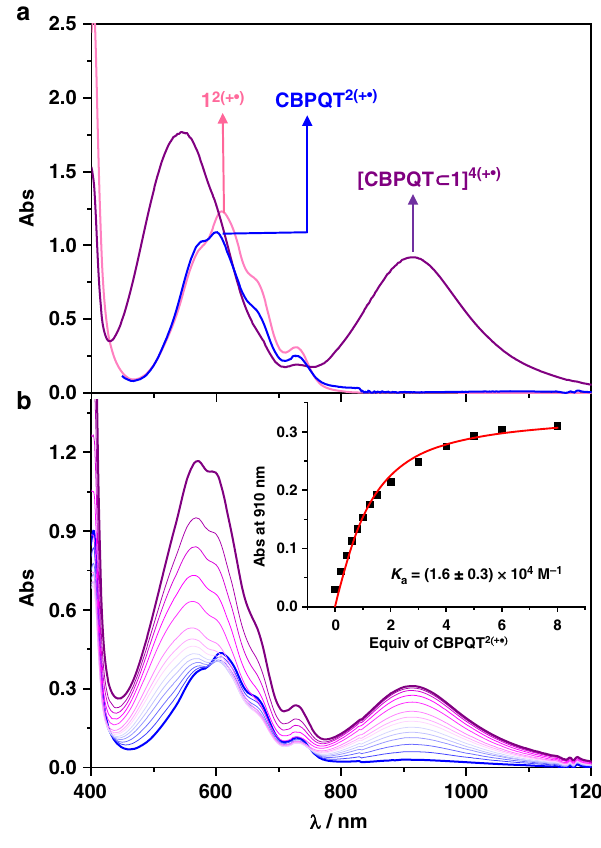
Fig. 3 UV – Vis – NIR characterization of [ CBPQT ⊂ 1 ] 4( + (cid:129) ) . a UV – Vis – NIR spectra (0.50 mM in MeCN, 1 mm path cuvette) of CBPQT 2( + (cid:129) ) (blue), 1 2 ( + (cid:129) ) (red), and a 1:1 molar ratio of CBPQT 2( + (cid:129) ) and 1 2( + (cid:129) ) (purple); b Vis/ NIR Spectra (MeCN, 2 mm cuvette) on titrating CBPQT 2( + (cid:129) ) into 1 2( (cid:129) + ) (0.10 mM). Initial and fi nal spectra are highlighted in blue and purple, respectively. The inset shows the change in absorption at 910 nm on titration of 1 2( + (cid:129) ) with CBPQT 2( + (cid:129) ) . Curve fi tting is highlighted in red